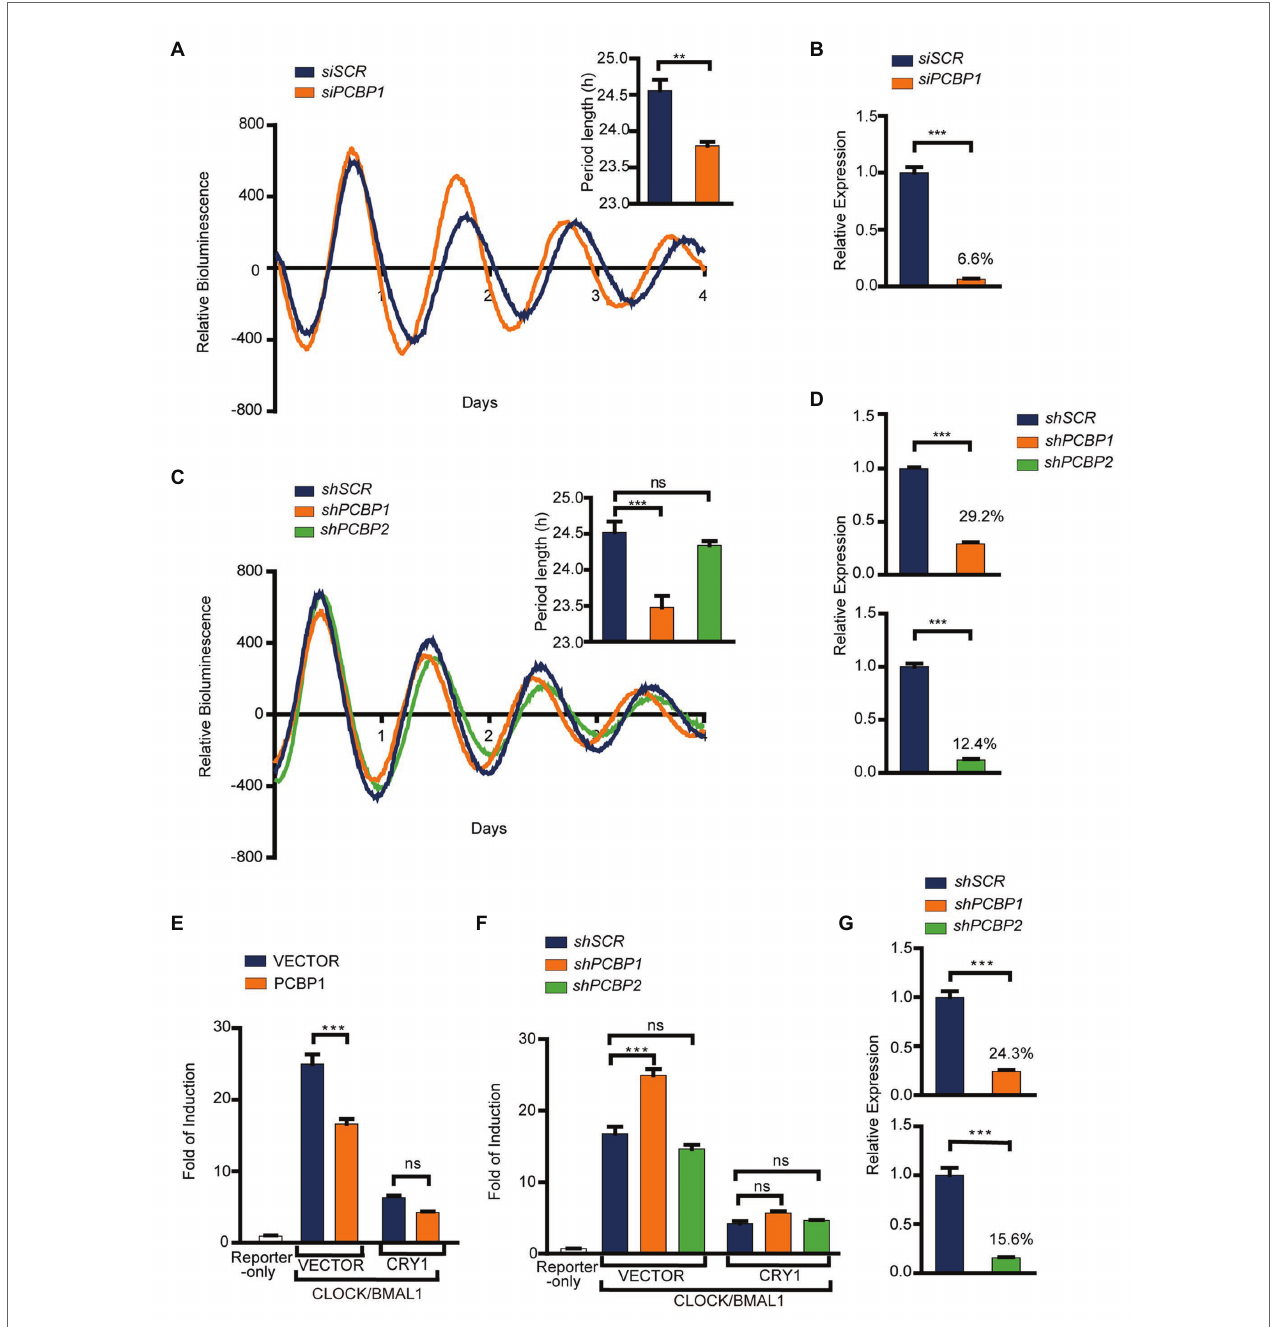
FIGURE 1 | PCBP1 is a period-short modifier for mammalian clocks. (A) Knockdown of PCBP1 results in a short period of circadian rhythm in U2OS cells harboring Per2-luc. Top right: Bars show quantitative period change values. (B) The knockdown efficiency of siPCBP1. The expression level of PCBP1 was knocked down to 6.6% compared to scramble. (C) Knockdown of PCBP1 using short hairpin RNA (shRNA) results in a short period of circadian rhythm in U2OS cells harboring Per2-luc, and the period had no obvious change in shPCBP2 cells. Top right: Bars show quantitative period change values. (D) The knockdown efficiency of shPCBP1 and shPCBP2 in U2OS cells harboring Per2-luc. The expression levels of PCBP1 and PCBP2 were 29.2 and 12.4% compared to scramble, respectively. (E) A transient transfection luciferase assay was conducted in 293 T cells to show that over-expressed PCBP1 decreased the transcriptional activity